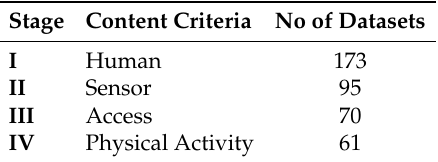
Table A2. Examined datasets per